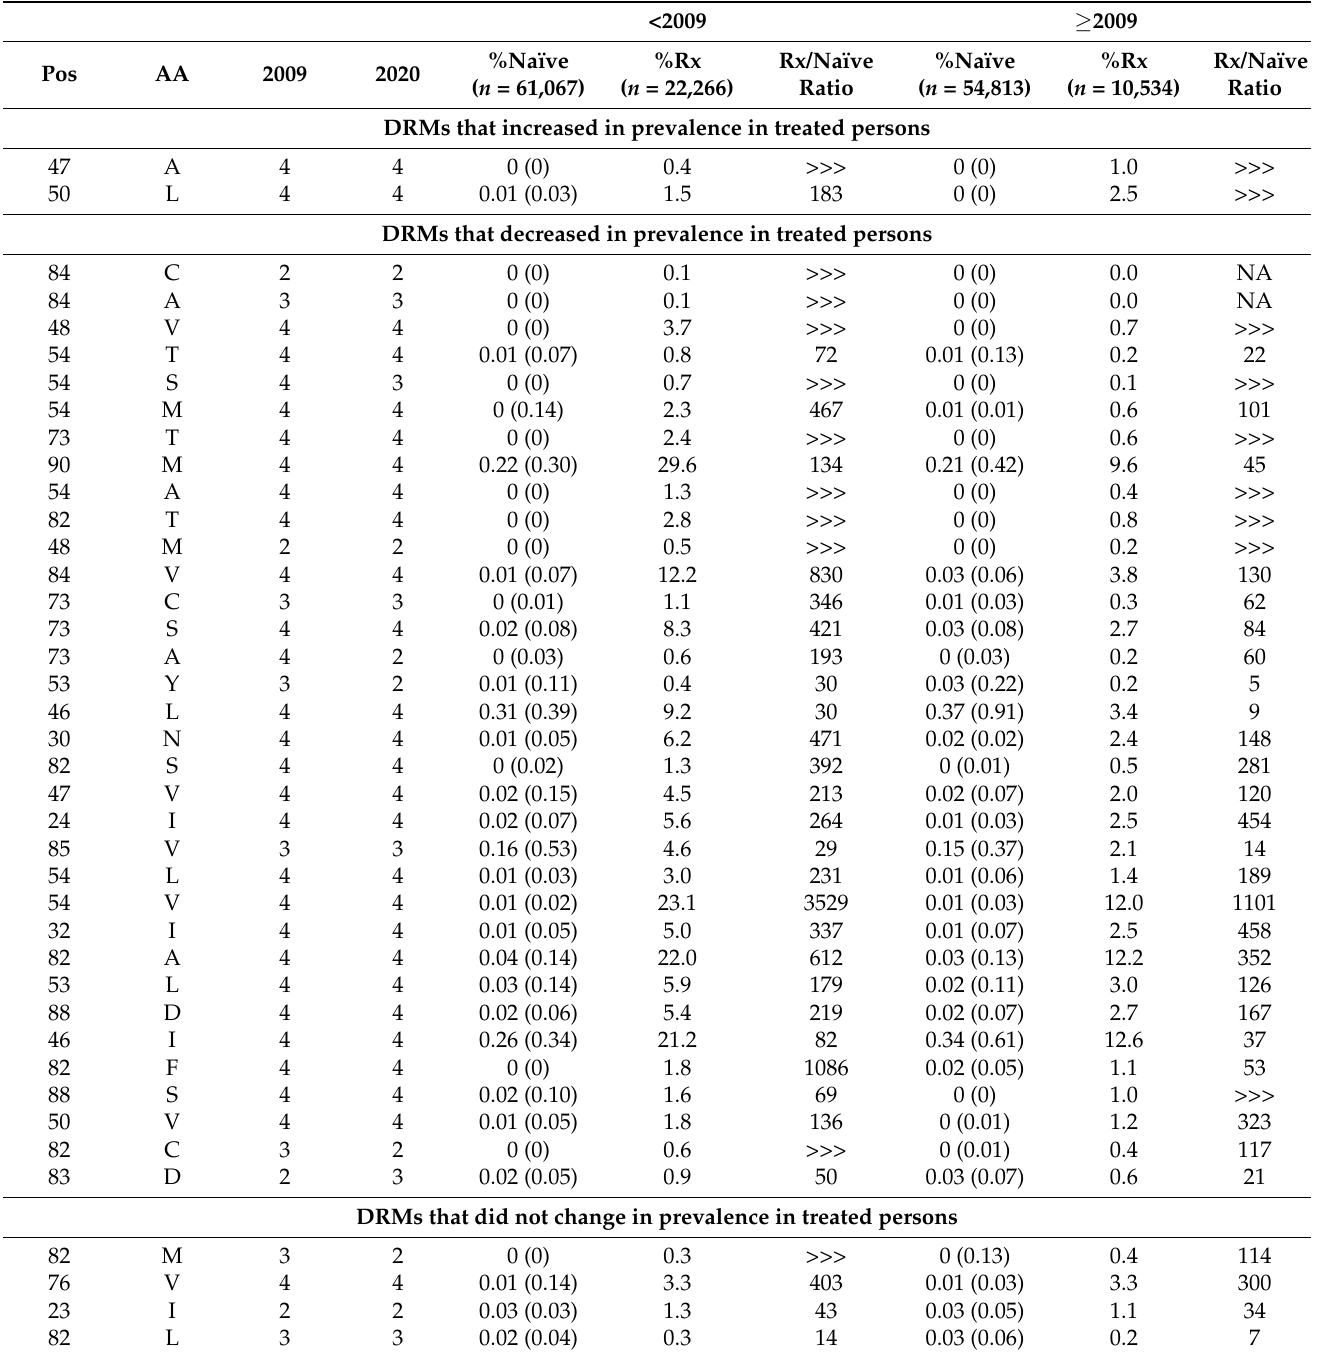
Table 5. Prevalence of Surveillance PI-Resistance Mutations in PI-Naïve and PI-Experienced Persons before and after